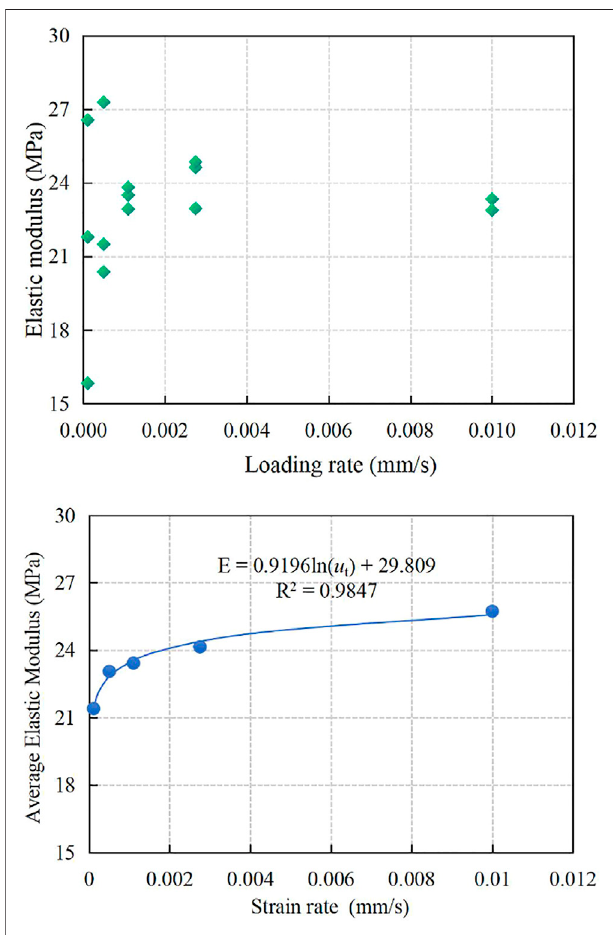
FIGURE 8 | Relationship between loading rate and elastic modulus.